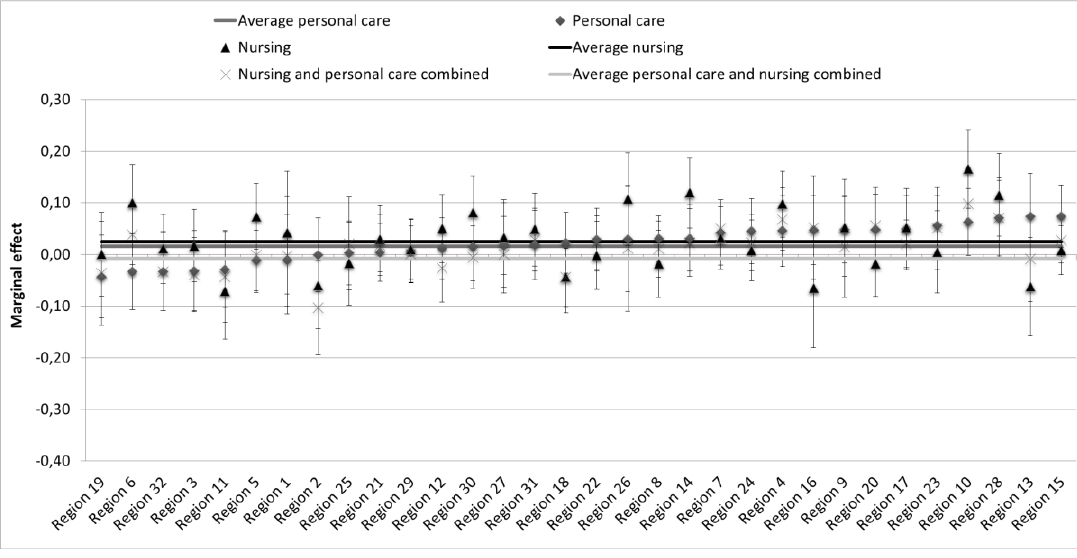
Figure A2: Variation in home care entitlements granted processed by CNAC